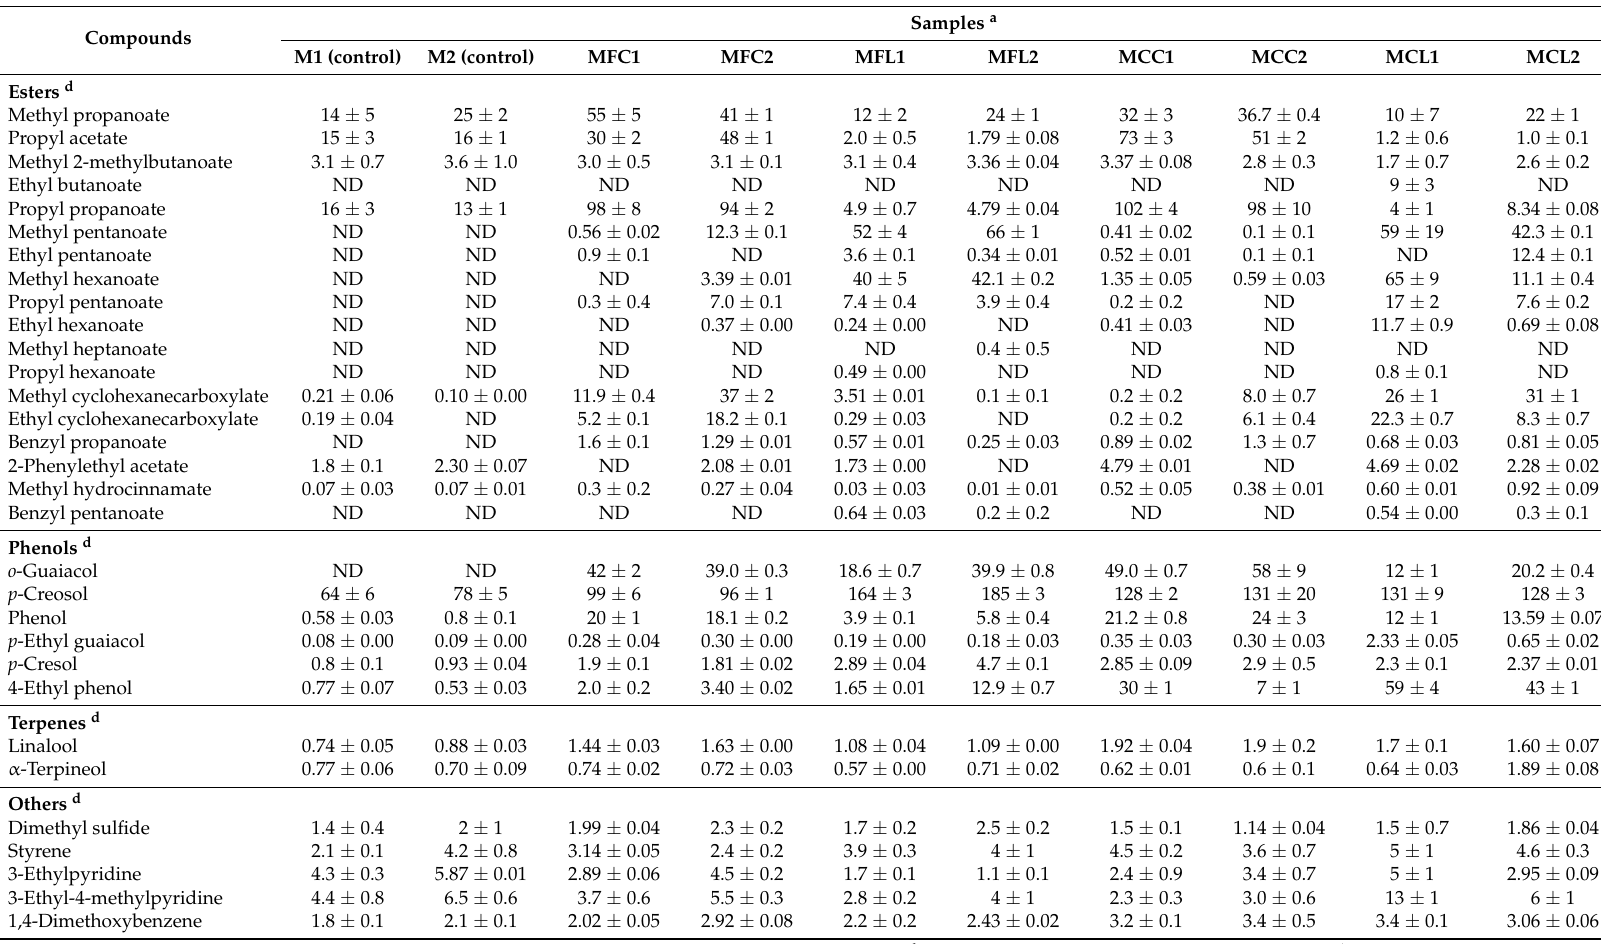
a Values are means ± SD. ND = not detected. See Table 5 for the meanings of samples abbreviations. b Quantitative determination expressed in g L − 1 . c Quantitative